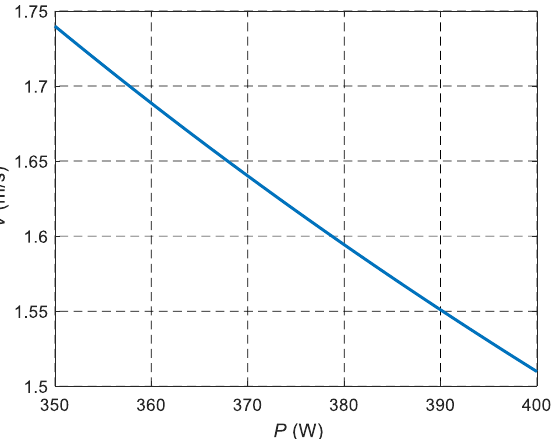
Figure 8. Scanning speed with respect to laser power supply needed to achieve high densification of SLMed Inconel 718 samples. This plot is useful for tuning scanning velocity with respect to laser power supply for the SLM of Inconel 718 in an independent dimensionless product range π 1 from 3.17 × 10 −8 to 4.6 × 10 −8 . Table 9. Chemical composition of AlSi10Mg powder used in [59]. Element Composition Table 10. Parameter values used to AM AlSi10Mg alloy samples. Experimental data taken from [59].